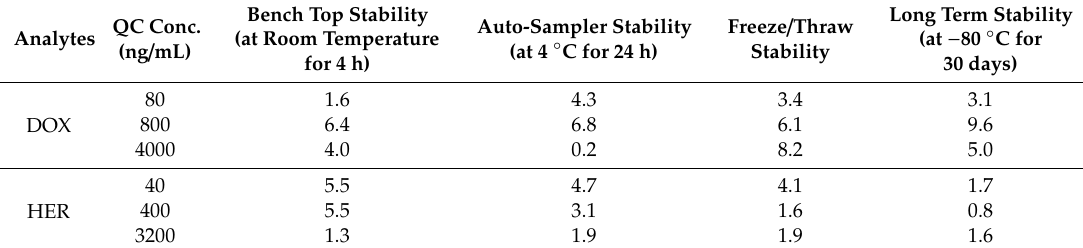
Table 4. Stability results for doxorubicin and hernandezine in plasma of rats under di ff erent storage conditions (n =